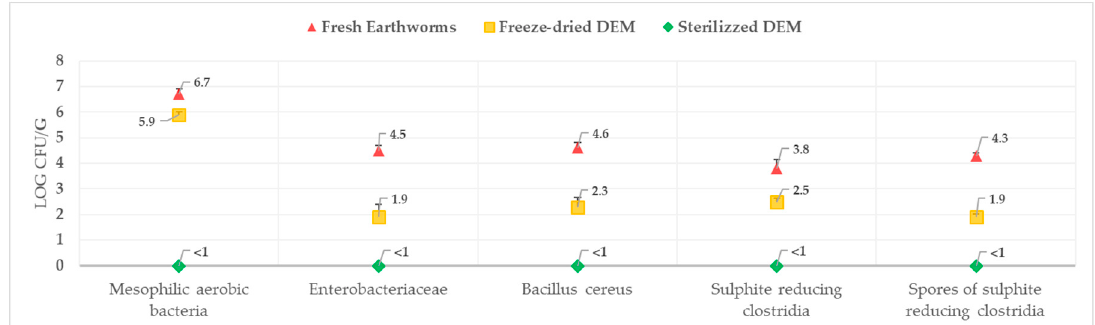
Figure 3. Results of microbiological analyses.